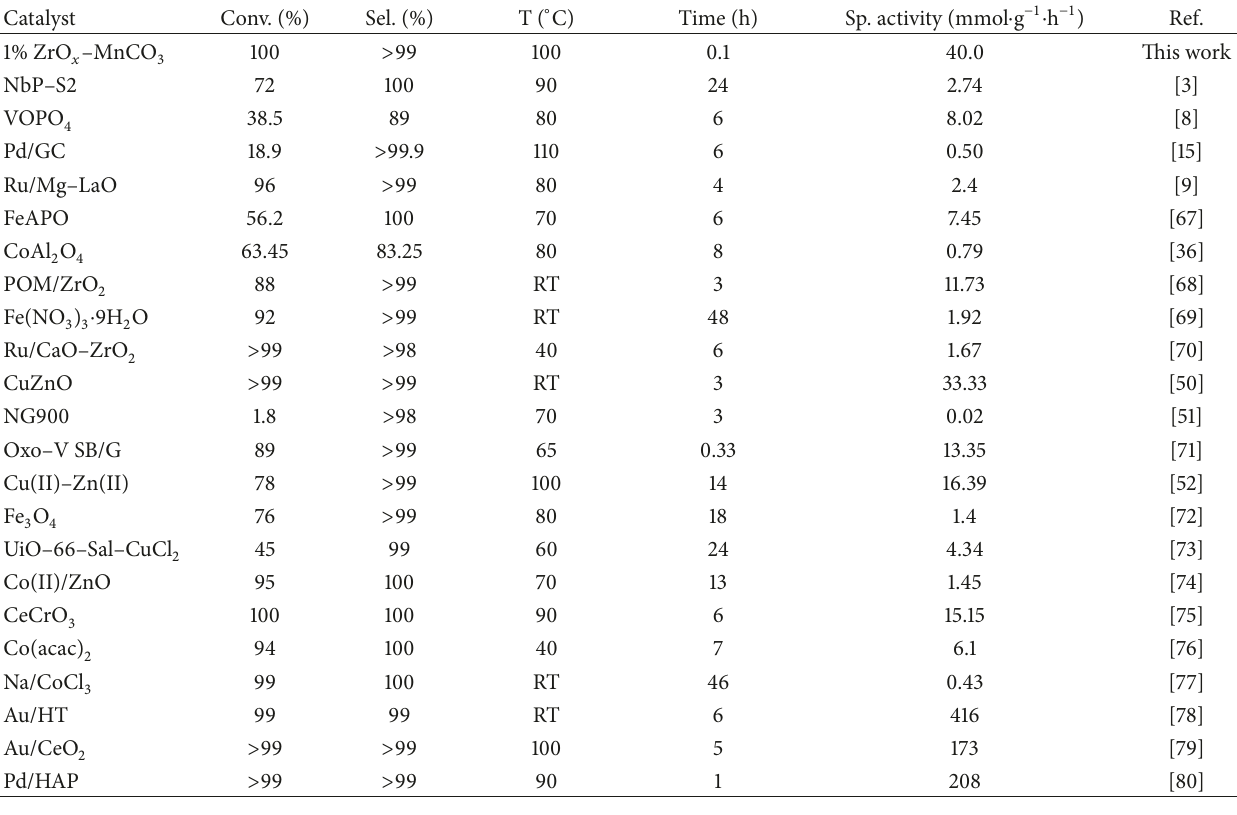
Table 5: Comparison between our work and earlier publications for the selective oxidation of 1-phenylethanol into acetophenone. Catalyst Conv. (%) Sel. (%)